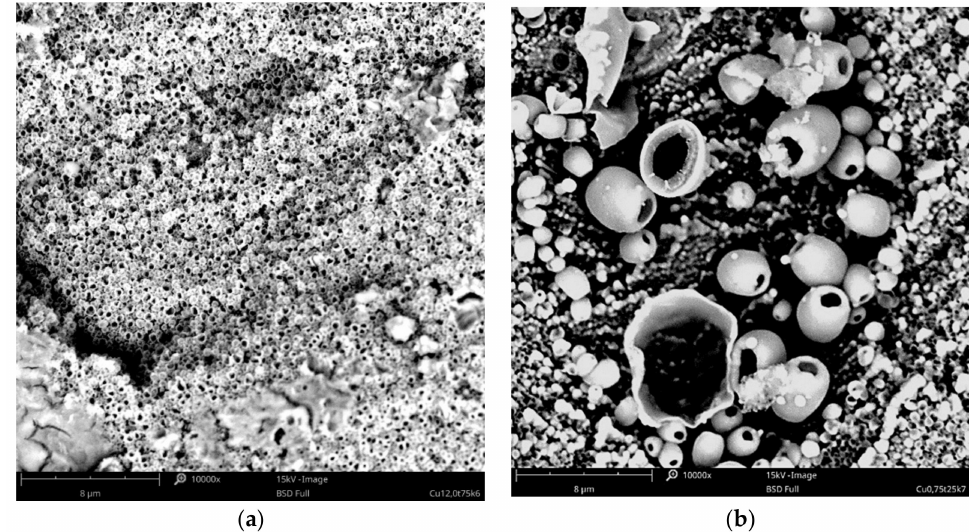
Figure 2. SEM images of the porous Cu coating electrodeposited in the bath with: ( a ) 30 g · L − 1 of CuAc (T = 75 ◦ C, j c = 12 mA · cm − 2 , t = 7.5 min); ( b ) 35 g · L − 1 of CuAc (T = 25 ◦ C, j c = 0.75 mA/cm − 2 , t = 1